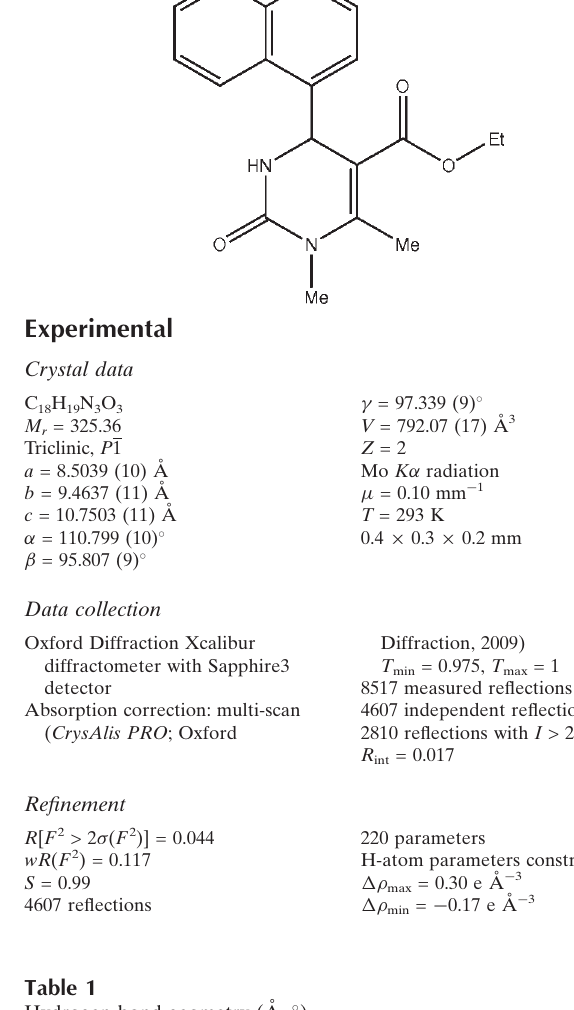
Hydrogen-bond geometry (A˚ , (cid:3) ). Cg 1 is the centroid of the C8–C13